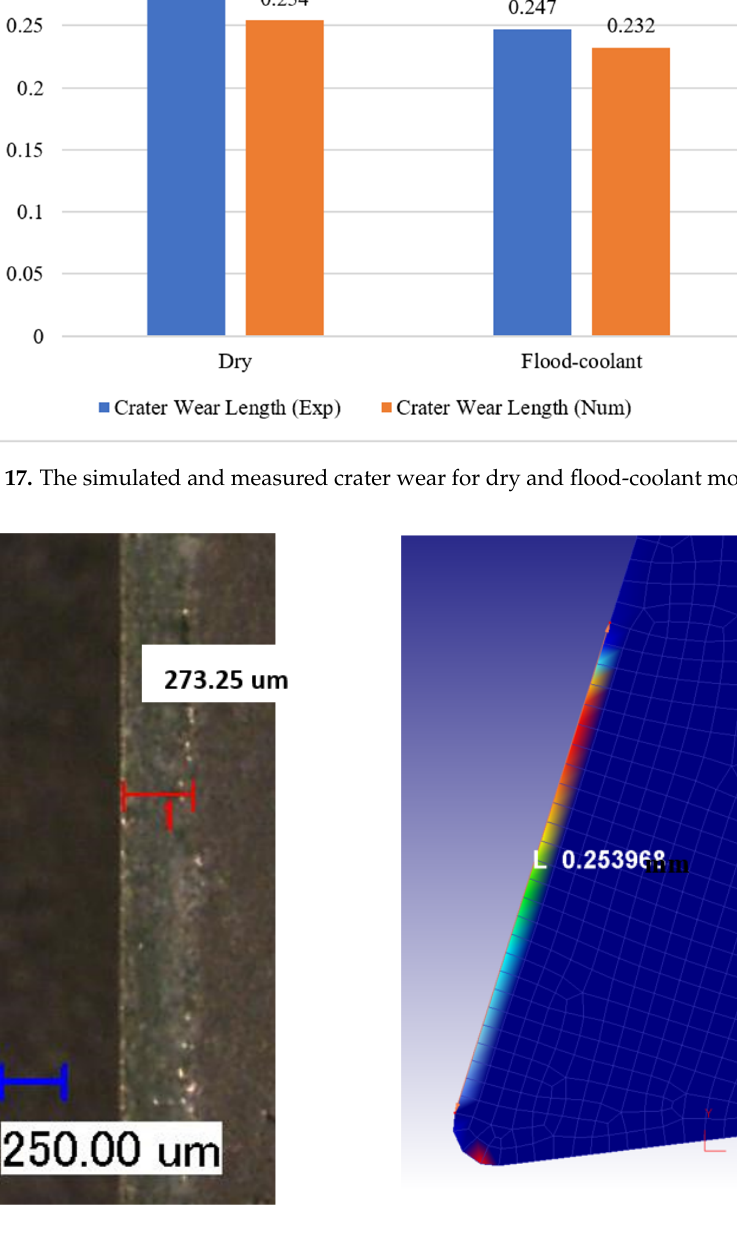
( b ) Figure 19. Crater wear for flood-coolant mode: ( a ) experimentally observed and ( b ) FE-simulated.